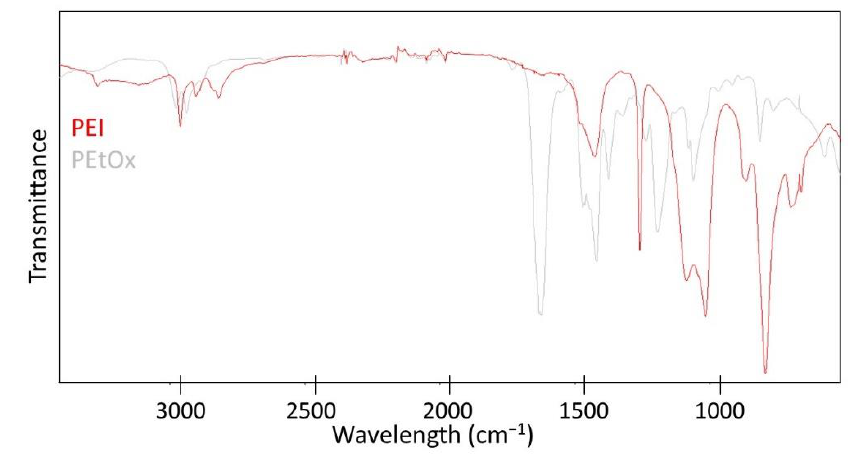
Figure 3. The ATR-FTIR spectra of PEtOx and PEI.